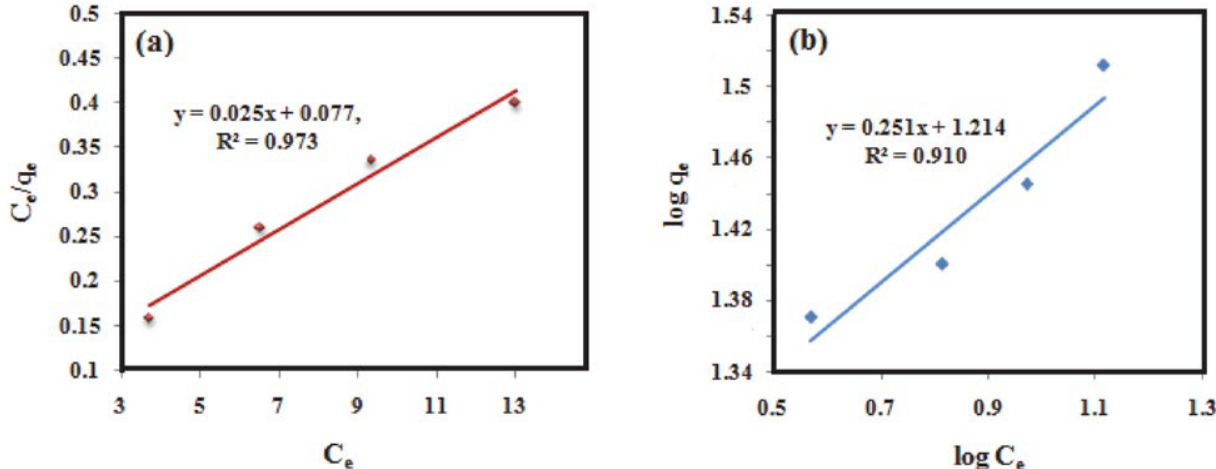
Figure 13. Adsorption isotherm plots for the adsorption of MB onto GO/Co